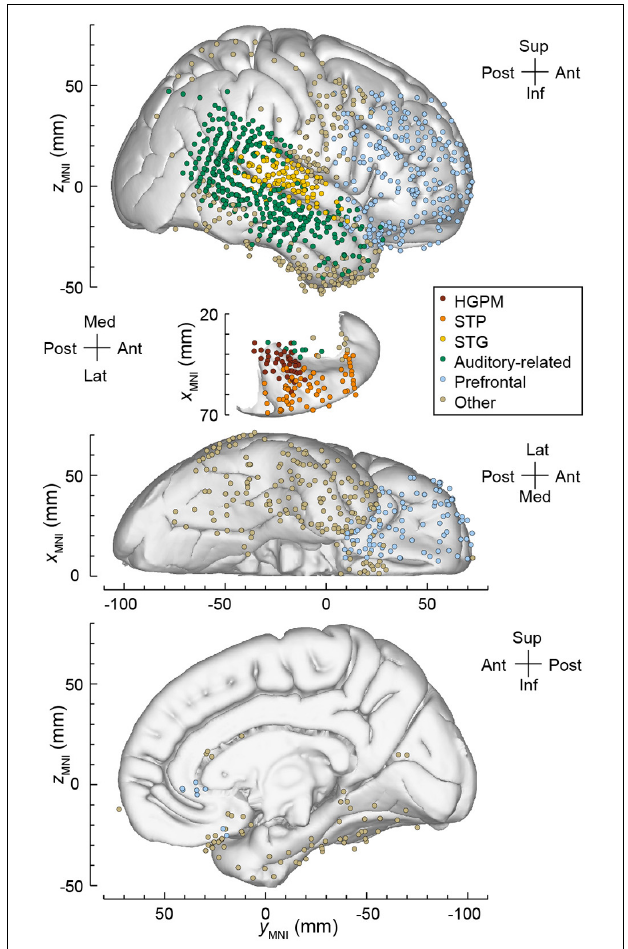
FIGURE 3 | Electrode coverage in all seven subjects. Locations of recording sites, color-coded according to the ROI, are plotted in MNI coordinate space and projected onto the right hemisphere of the Freesurfer average template brain for spatial reference. Left hemisphere MNI x -axis coordinates ( x MNI ) were multiplied by –1 to map them onto the right-hemisphere common space. Projection is shown on the lateral, top-down (STP), ventral and mesial views (top to bottom) . Recording sites over orbital, transverse frontopolar, inferior temporal gyrus and temporal pole are shown in both the lateral and the ventral view. Sites in fusiform, lingual, parahippocampal gyrus and gyrus rectus are shown in both the ventral and medial view. Sites in the hippocampus ( n = 13), amygdala ( n = 12), frontal operculum ( n = 5), parietal operculum ( n = 3), substantia innominata ( n = 5), putamen ( n = 1), and uncus ( n = 1) are not shown. HGPM, posteromedial portion of Heschl’s gyrus; STP, superior temporal plane; STG, superior temporal